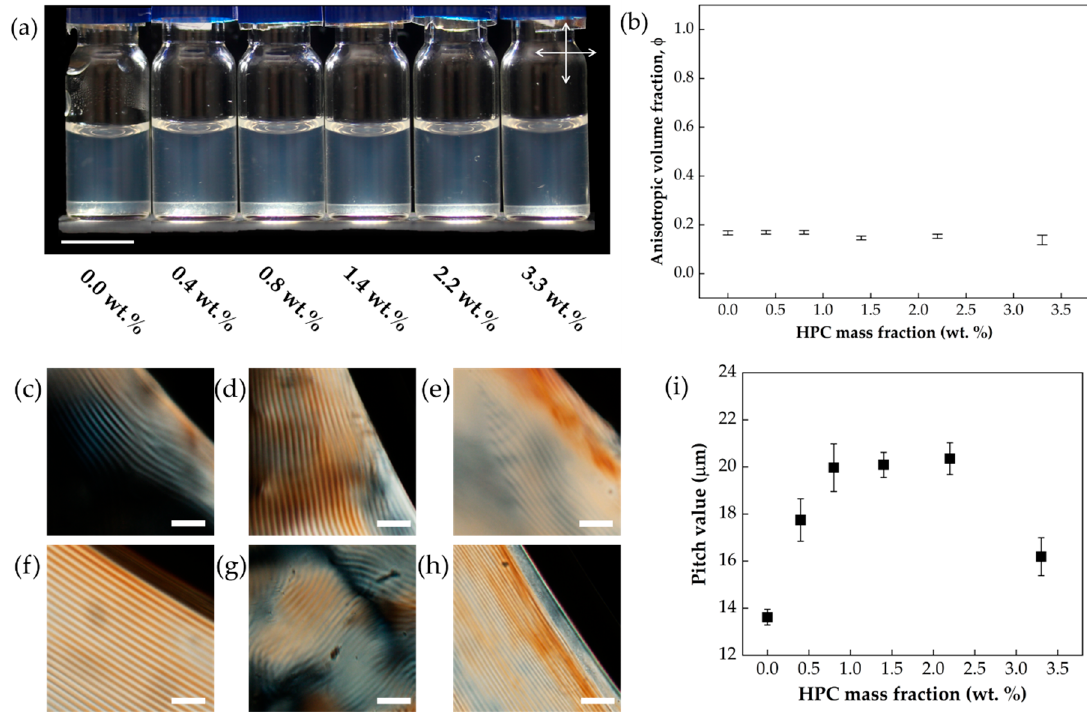
Figure 1. ( a ) Photograph obtained between crossed-polars of the phase separation observed on a lyotropic CNCs suspension with concentration 3.3 wt.% (first vial) and CNCs / HPC aqueous suspensions with di ff erent concentrations of HPC added while the concentration in CNCs is constant; ( b ) Phase diagram of CNCs / HPC / H 2 O system, represented by the volume fraction, φ , of the anisotropic phase as a function of HPC concentration where no apparent change is observed when compared with the pristine lyotropic LC CNCs / H 2 O system; ( c–h ) POM images obtained in transmission mode with crossed-polars of neat CNCs / H 2 O and CNCs / HPC / H 2 O suspensions; ( i ) chiral nematic pitch value plotted as a function of the HPC content in the mixtures of CNCs / HPC / H 2 O. Scale bars: ( a ) 1 mm; ( c – e ) 50 µ